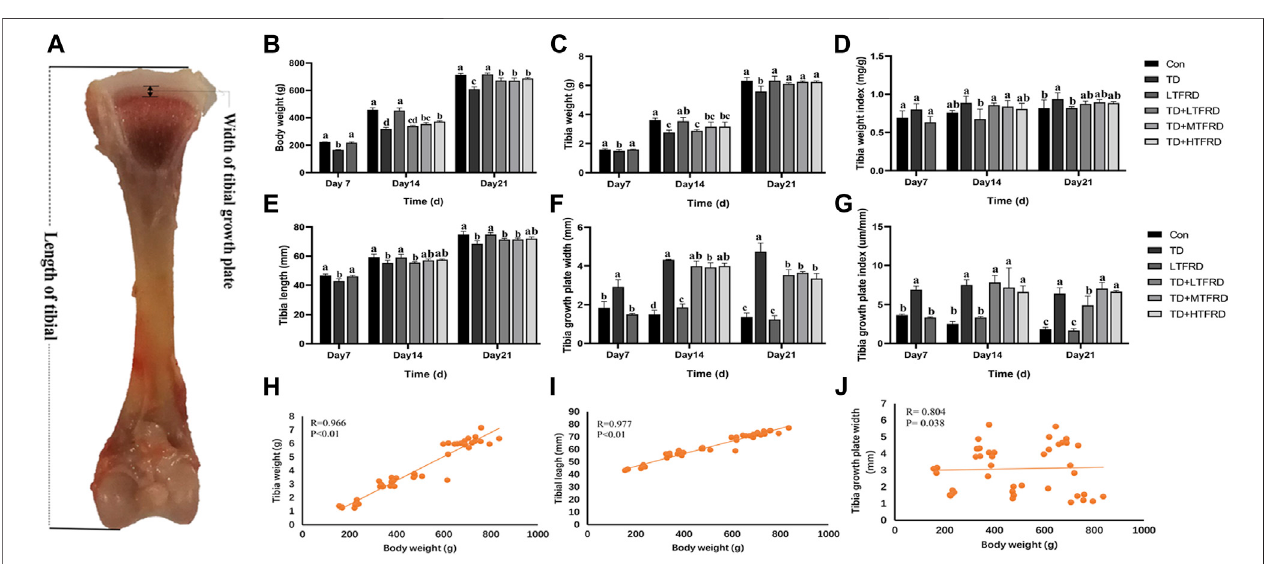
FIGURE 1| Effects of TFRD on tibial growth in TD broilers. (A) The tibial of chickens. (B) Body weight ofchickens. (C) Tibia weight. (D) Tibia weight index. (E) Tibia length. (F) Tibia growth plate width. (G) Tibia growth plate index. (H) The pearson correlation analysis between tibia weight and body weight. (I) The pearson correlation analysis between tibia length and body weight. (J) The pearson correlation analysis between tibia growth plate width and body weight. The results are represented as mean ± SD. a, b, c, and d represent signi fi cant differences between groups ( p < 0.05).